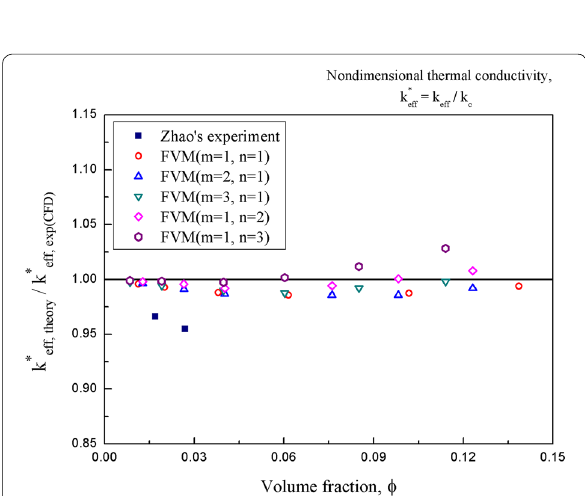
Fig. 11 Comparisons of models, experimental data, and FVM results for the reinforced concrete containing multiple round